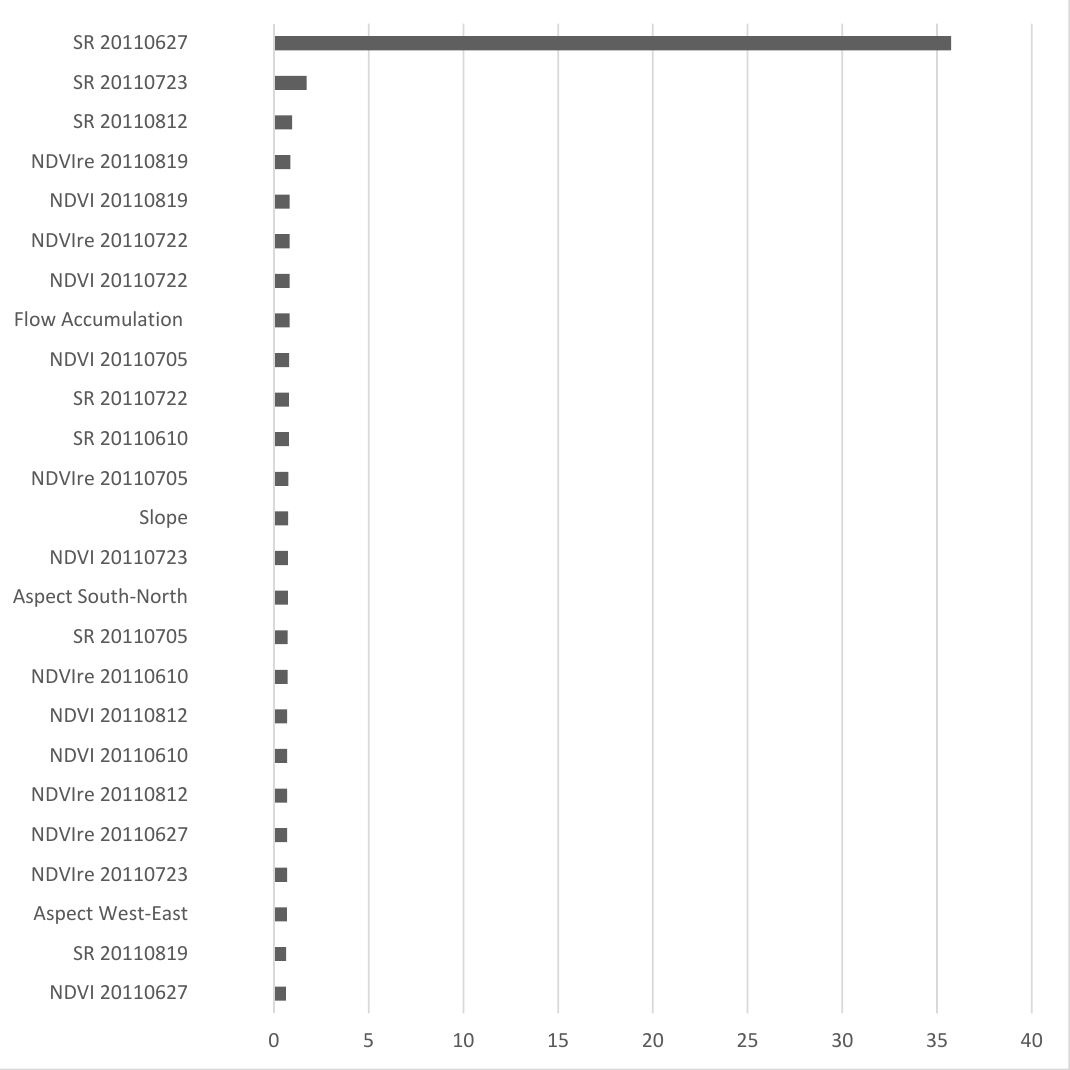
Figure A3. Importance of variables for the corn 2011 ANN model, as measured by Garson values (larger values indicate higher importance).